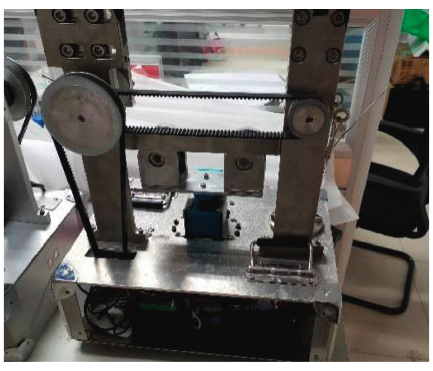
Figure 6: Actual object of line changing